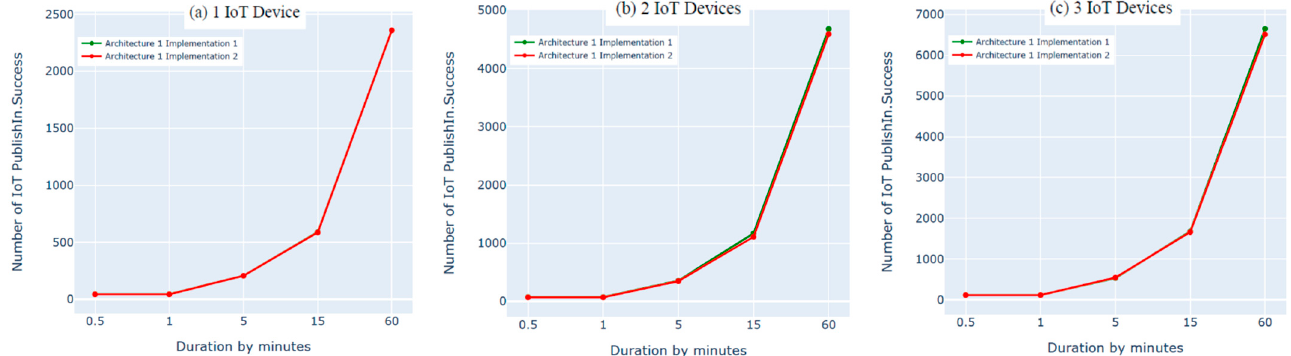
Figure 10. AWS IoT message broker PublishIn.Success metric with 1, 2, and 3 IoT devices on North Virginia datacenter (cloud layer).